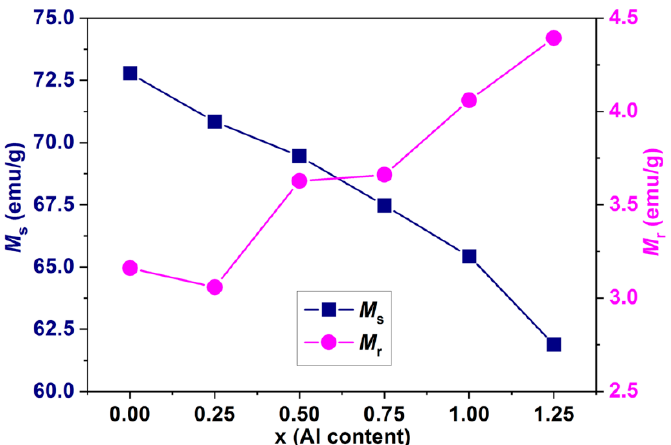
Figure 8. Effects of Al content (x) on the saturation magnetization ( M s ) and remanent magnetization ( M r ) of the W-type SrYb hexaferrite Sr 0.85 Yb 0.15 Zn 1.5 Co 0.5 Al x Fe 16-x O 27 .